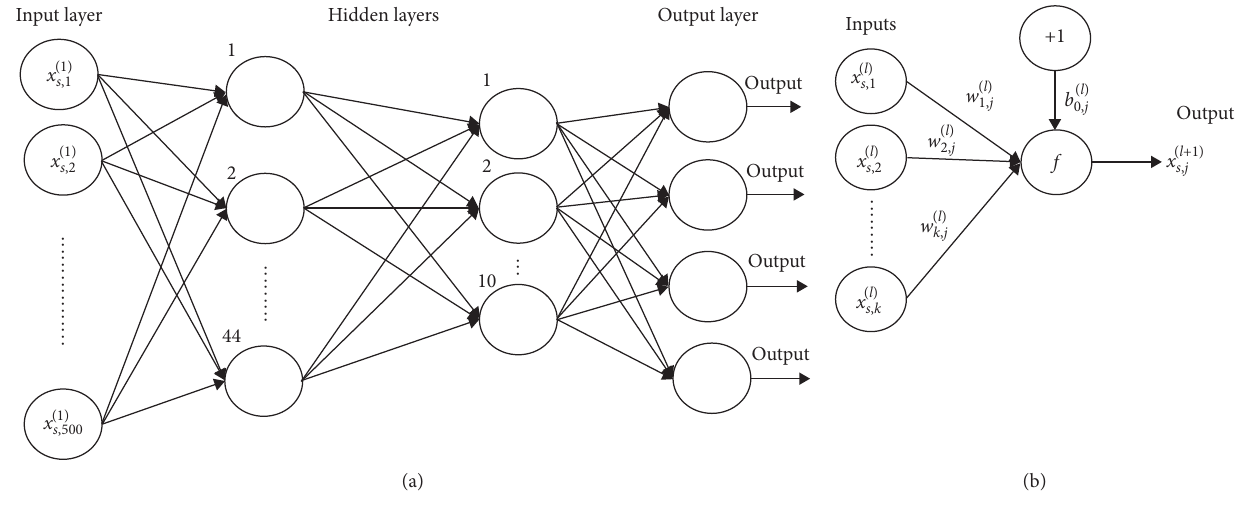
Figure 5: (a) Structure of the MLP feedforward ANN and (b) schematic of a